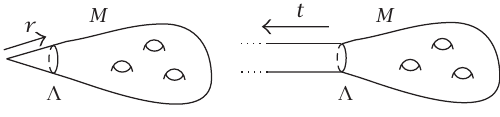
Figure 3.3. Cylindrical